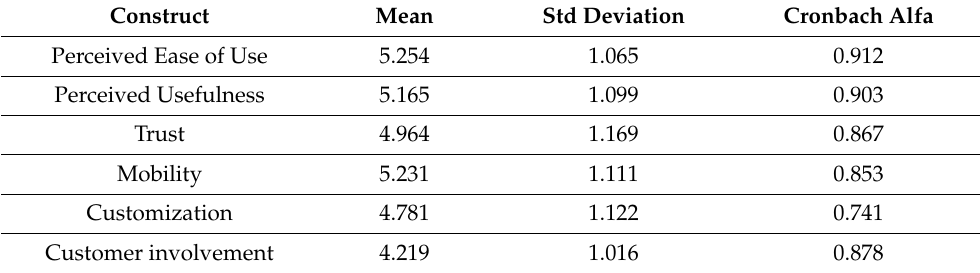
Table 3. Reliability